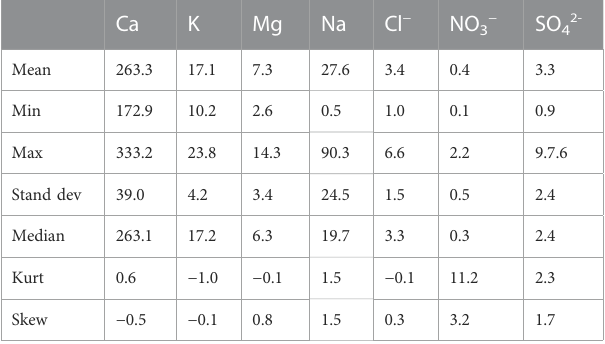
TABLE7Concentrationsofmajorcationsandanionsindustssampledfromthe Abu Dhabi-Liwa Highway